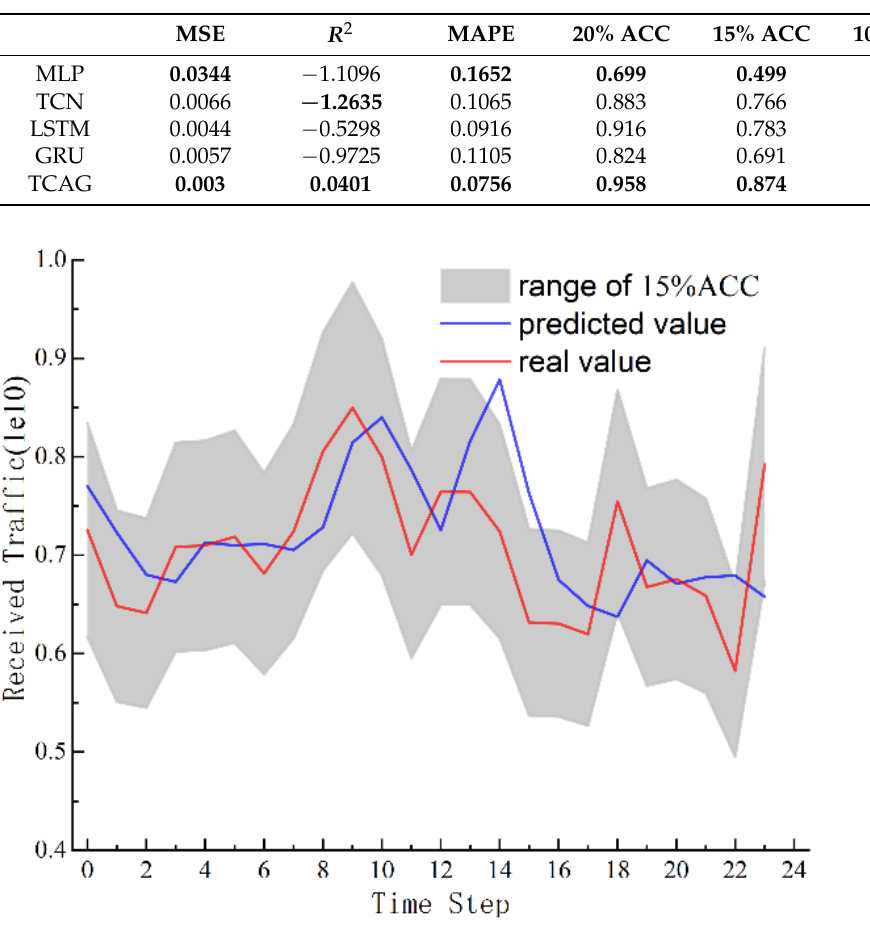
Figure 9. MLP model prediction results.